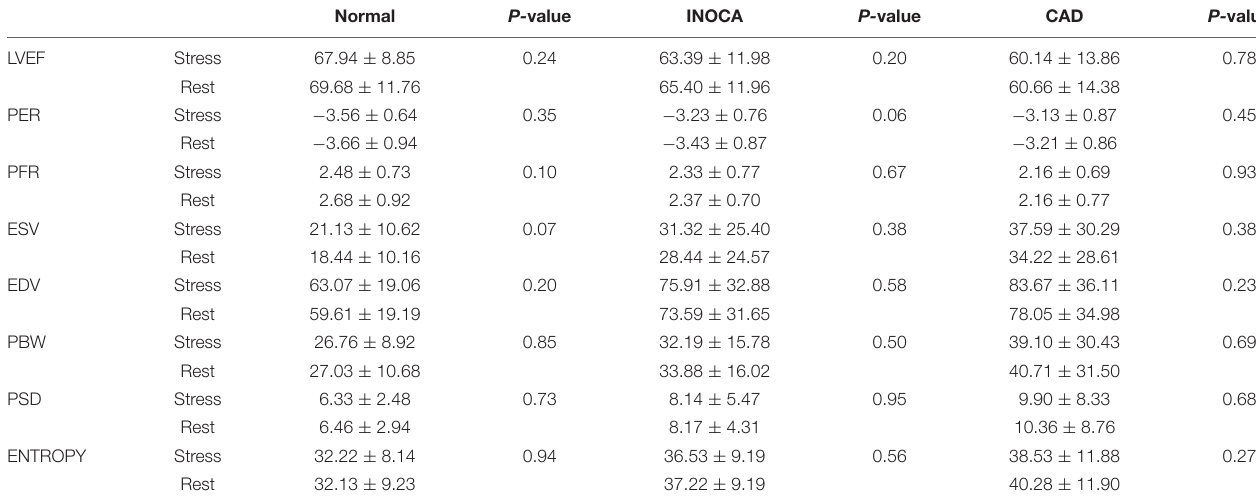
The bolded values and * both represent P < 0.05. TABLE 3 | Stress-induced changes in LV functions and LVMD parameters between three groups. Normal P- value INOCA P- value